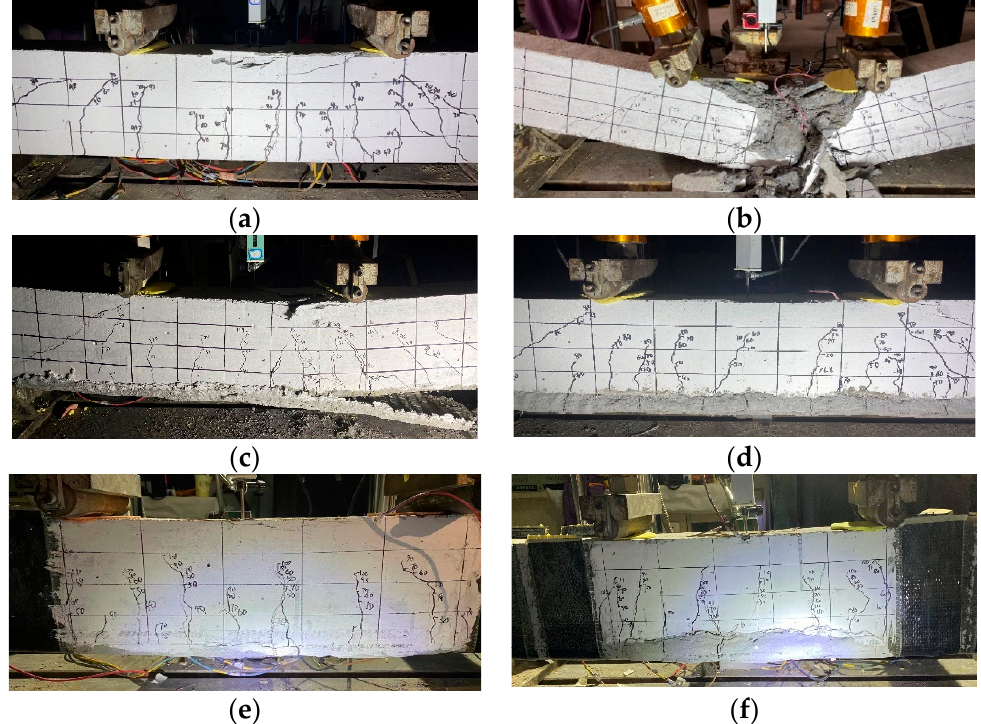
Figure 8. Failure modes of control and strengthened concrete beams. ( a ) B0. ( b ) B-1. ( c ) B-3. ( d ) B-5. ( e ) B-3-E. ( f ) B-5-E.